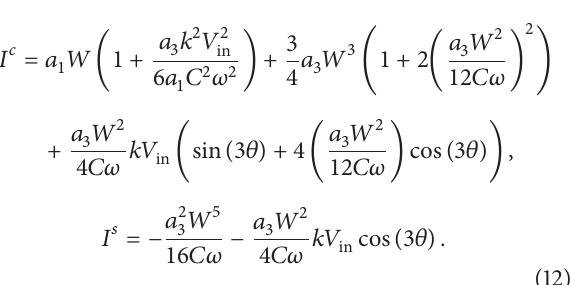
Figure 9: SPICE simulation of the circuit in Figure 5 obtained by using BSIM3 transistor models in MOSIS-IBM 8RF 0.13 𝜇 technol- ogyand 𝑊/𝐿 𝑐 = 𝑊/𝐿 𝑖 = 24/0.12 , 𝑊/𝐿 1.2 V, 𝐿 = 10 nH, 𝑅 = 905 Ω . (a) Voltages at the input and output terminals. (b) Frequency spectrum of the output